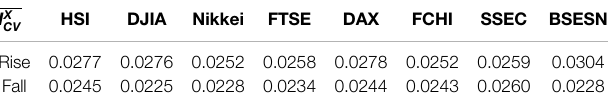
TABLE 2 | Rise and fall I CV values of eight stock indices.